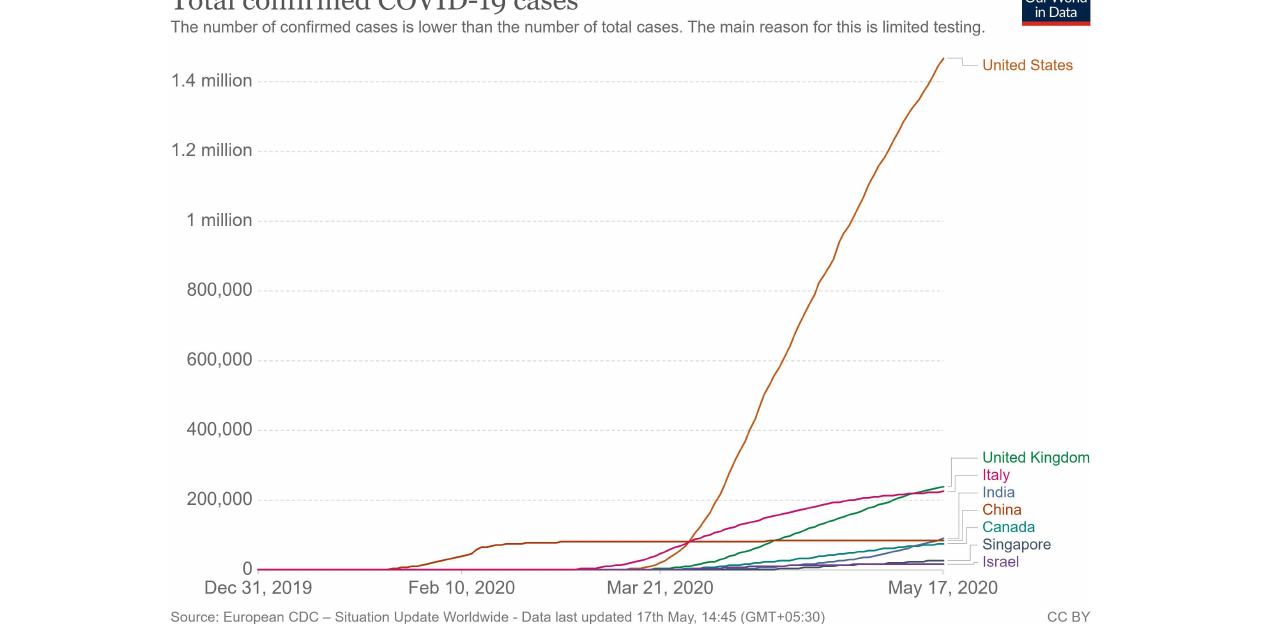
FIGURE 2 | Total confirmed COVID 19 cases as of May 2020